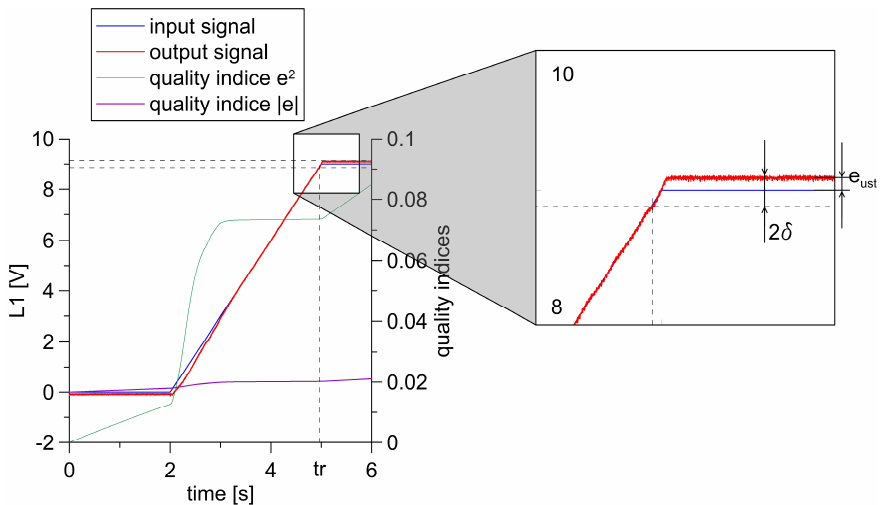
Figure 9. The dynamic characteristics and displacement analysis of actuator A1.